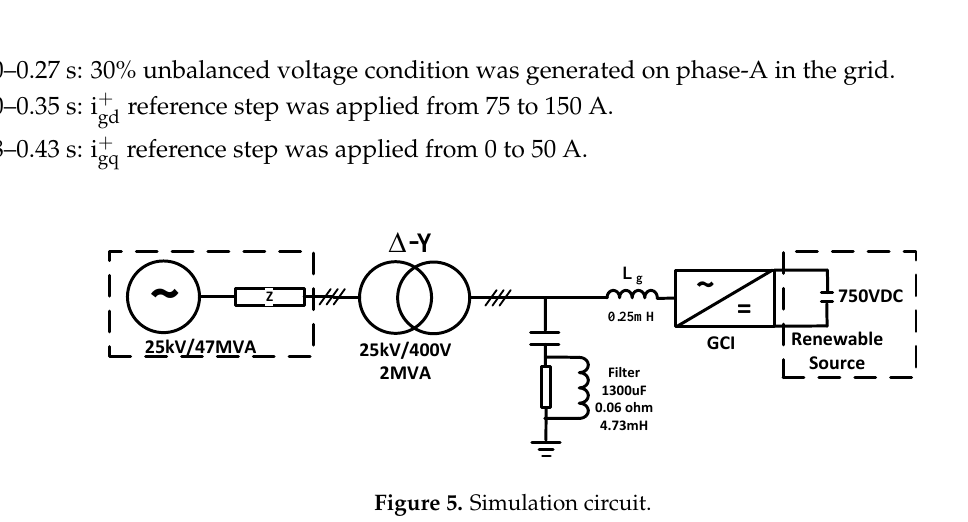
Figure 7. Simulation A results without dual positive- and negative-sequence controllers: ( a ) P ss2 (kW) and P sc2 (V) components, and ( b ) i gd− (A) and i gq− (A). Similarly, Figure 8 shows the second simulation results (Simulation B) with dual positive- and negative-sequence current controller results. The negative-sequence controller was only enabled when an unbalanced voltage existed in the grid because it was observed in simulations that enabling the negative-sequence controller in balanced voltage conditions unnecessarily deteriorated the dynamic performance of the overall system [45]. Thus, a simple logic condition was added in the simulation